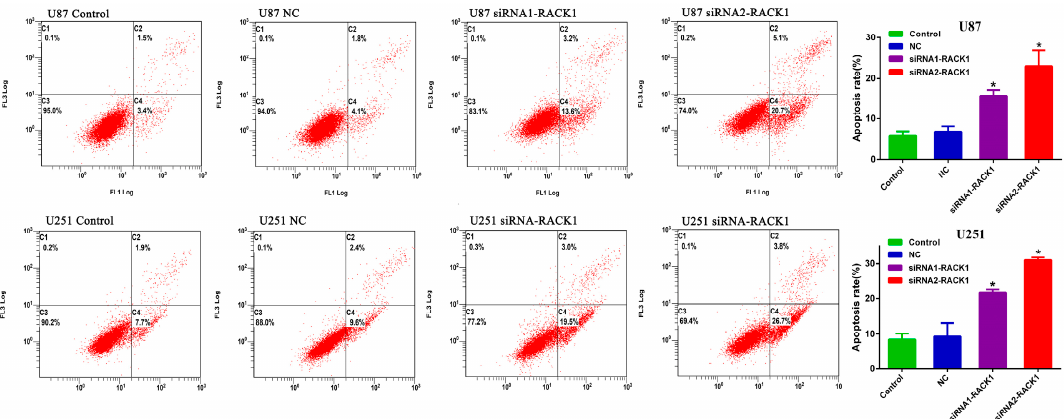
Figure 5. Annexin V-FITC/PI staining and flow cytometry analysis demonstrated that knockdown of RACK1 dramatically enhanced the apoptosis rate compared with negative control (NC) groups both in U87 and U251 cells. * p < 0.05.